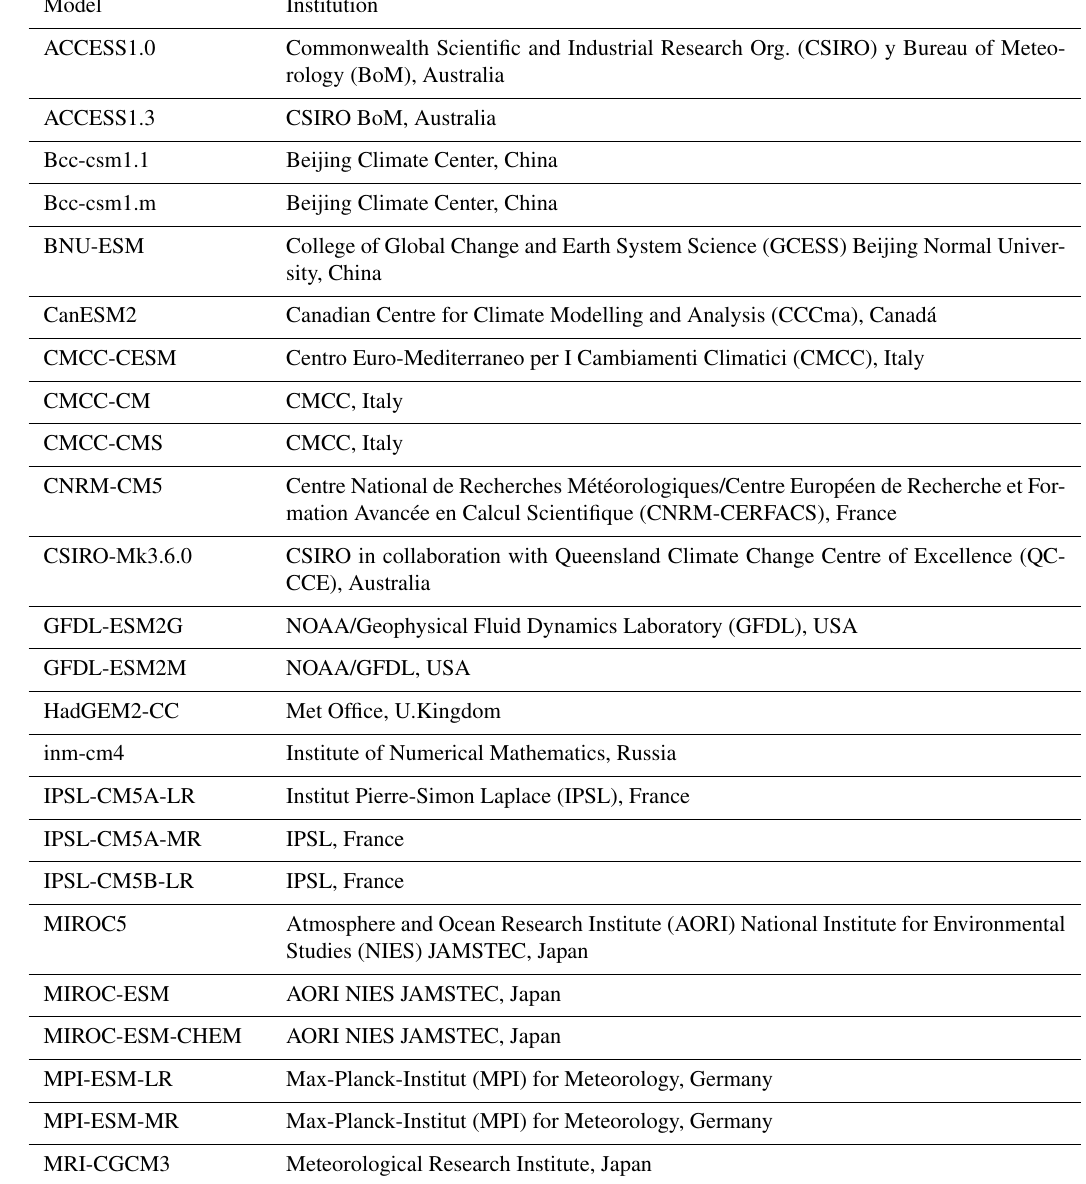
Table 2. List of GCMs used for their downscaling with two statistical downscaling methods (see interpretation of acronyms and models.